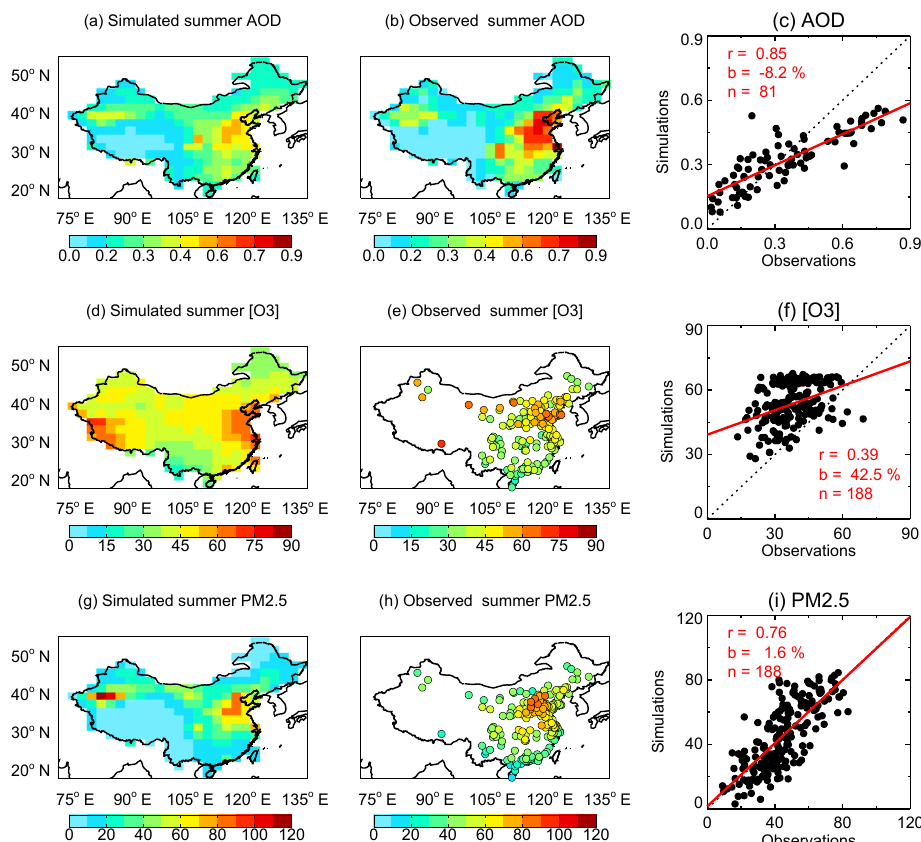
Figure 2. Evaluation of simulated summertime air pollution in China. Evaluations shown include (a) aerosol optical depth (AOD) at 550nm, (d) [O 3 ] (units: ppbv), and (g) PM 2 . 5 concentrations (units: µgm − 3 ) with observations from (b) the satellite retrieval of the MODIS (averaged for 2008–2012), and (e, h) measurements from 188 ground-based sites (at the year 2014). Simulation results are from G10ALLNO3 performed with the climate model ModelE2–YIBs (Table 2). The correlation coefficients ( r ), relative biases ( b ), and number of sites or grids ( n ) for the comparisons are listed on the scatter plots.